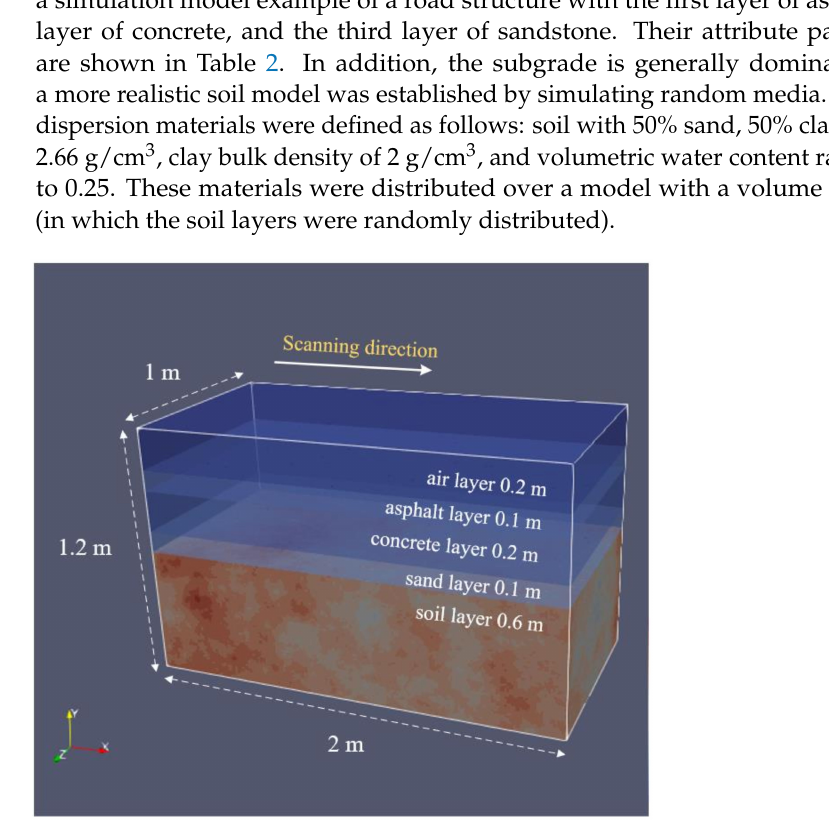
Figure 11. Road structural simulation model. Table 2. Dielectric properties of road